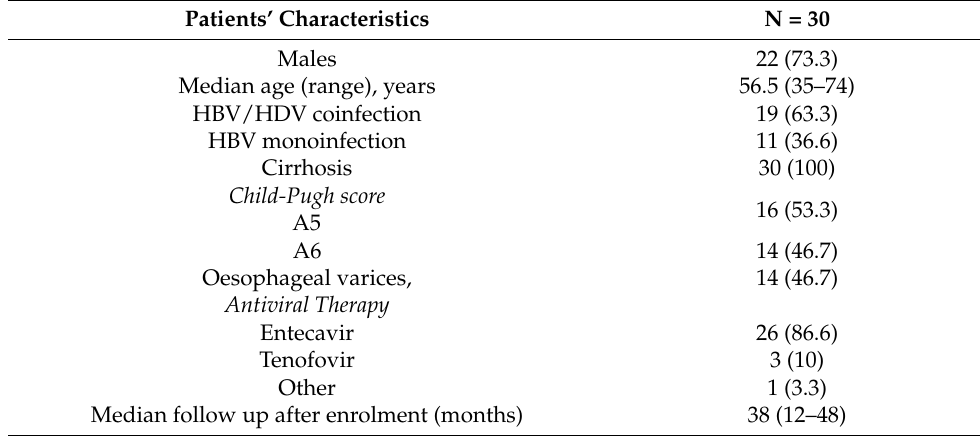
Table 1. Characteristics of the study